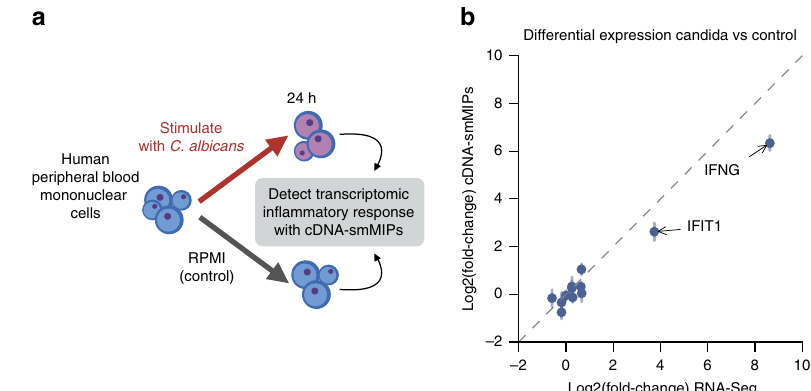
Figure 4 | Expression changes following stimulation of PBMCs. ( a ) Outline of PBMC stimulation experiment. ( b ) Concordance of differential gene expression ( Candida versus Control) estimates from cDNA-smMIPs and previously published RNA-Seq data 16 . The cDNA-smMIPs and RNA-Seq experiments were performed on PBMCs from different individuals.